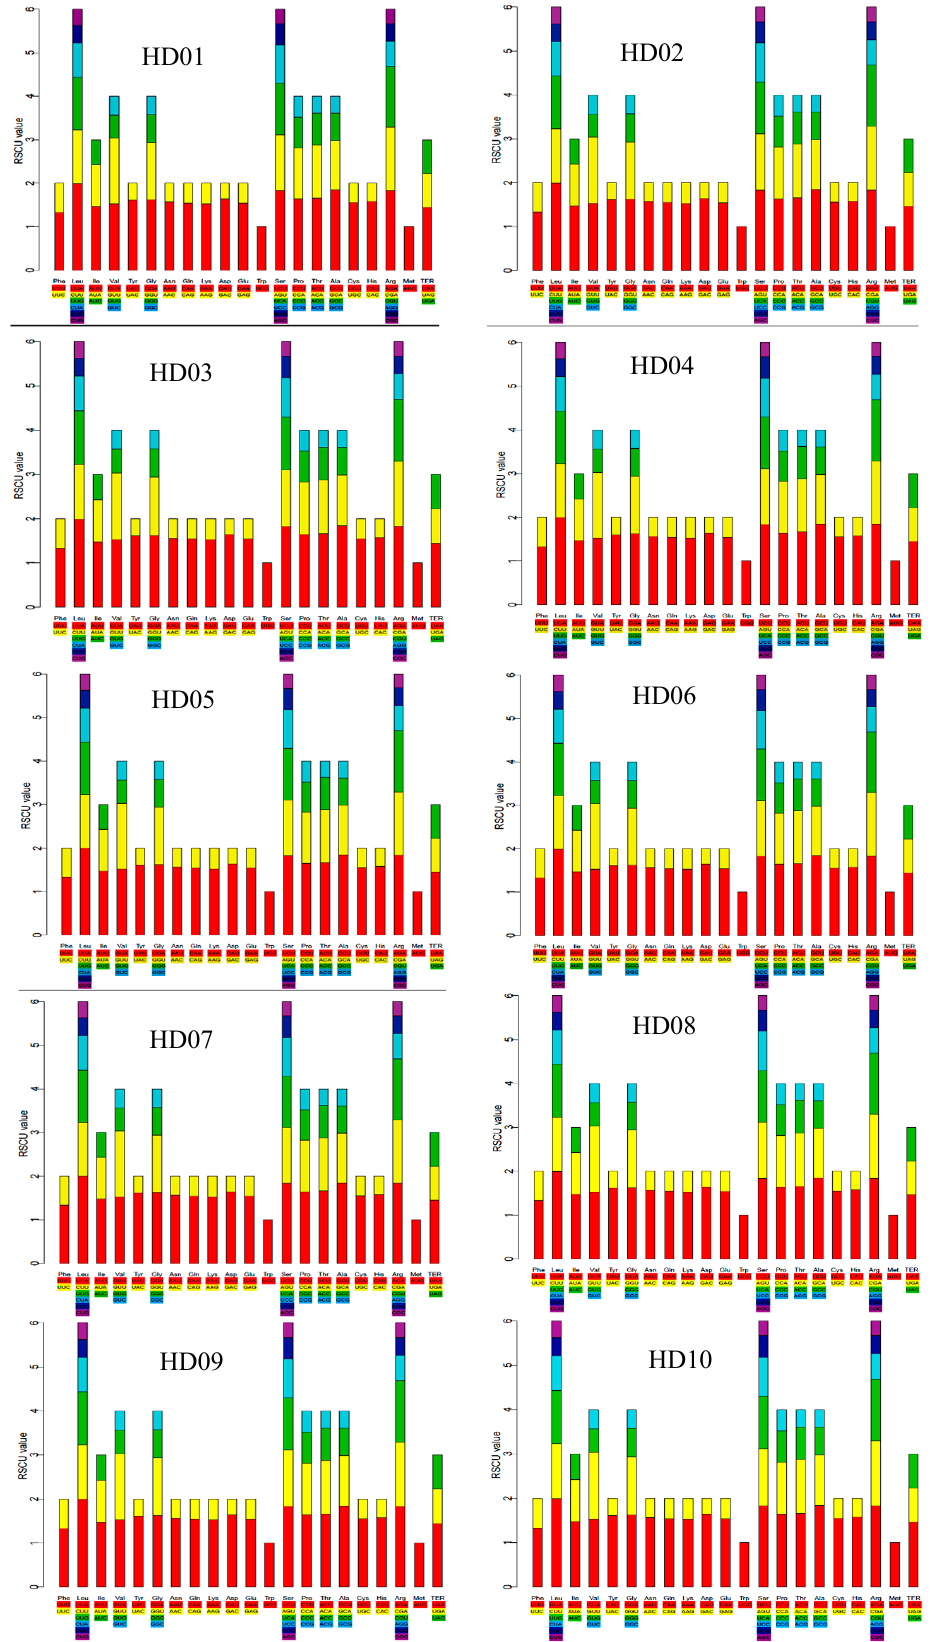
Figure 2. RSCU of the codons in the cpDNA of all samples.